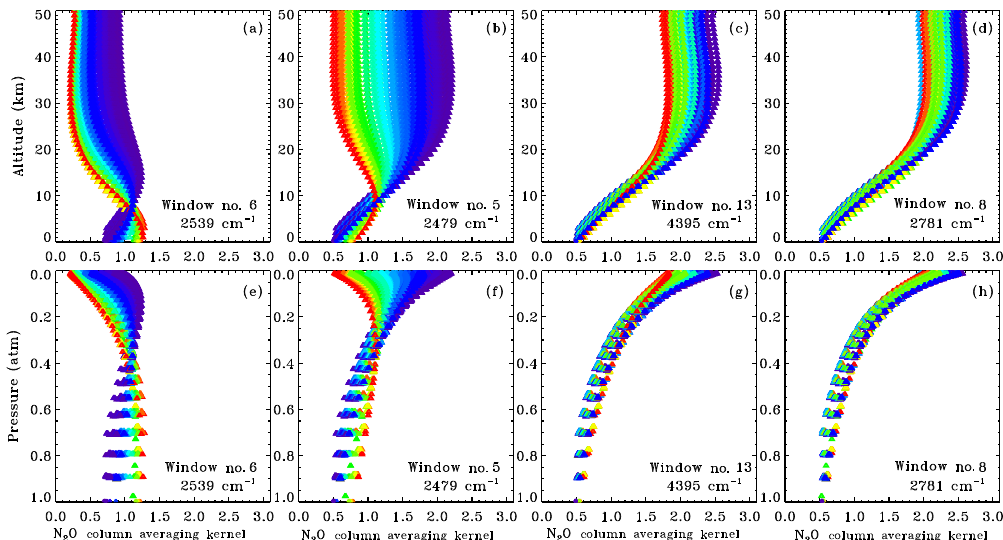
Figure C1. Averaging kernels for four N 2 O windows color-coded by air mass. Red denotes an air mass of 9, orange 7, green 5, cyan 3, blue 2, and purple 1. Panels (a, b, c, d) plot kernels versus altitude; (e, f, g, h) plot the same kernels versus pressure. Panels (a, e) show results for 2539cm − 1 , which we did not use in the final analysis because N 2 O lines were too strong. Panels (b, f) show the less strong 2479cm − 1 window. Panels (c, g) show the medium strength 4395cm − 1 window. Panels (d, h) show kernels from the 2781cm − 1 window containing weak N 2 O